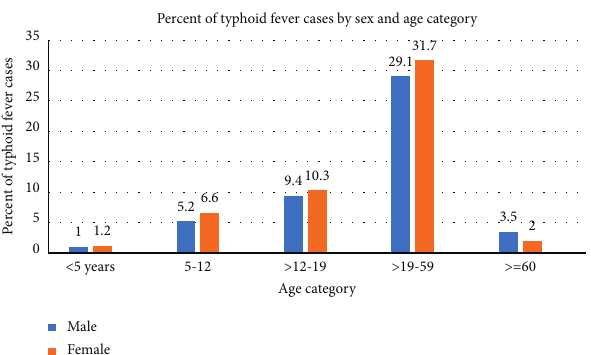
Figure 2: Distribution of typhoid fever cases by sex and age category in the Jimma Zone, Oromia Region, Southwest Ethiopia, from 2015 to 2019. Table 1: Incidence of typhoid fever by year in the Jimma Zone, Oromia Region, Southwest Ethiopia, from 2015 to 2019. Years